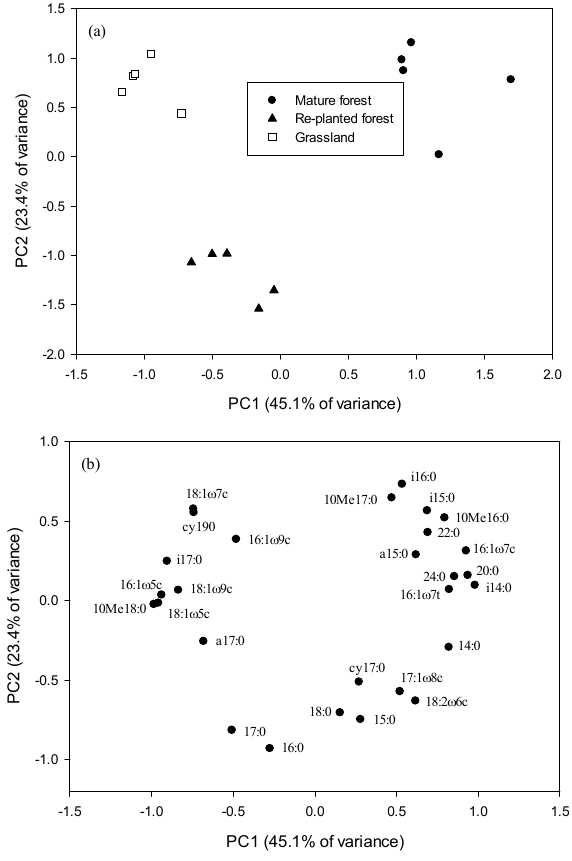
Figure 2. Plots of ( a ) the first 2 principal components (PCs) and ( b ) corresponding loading values